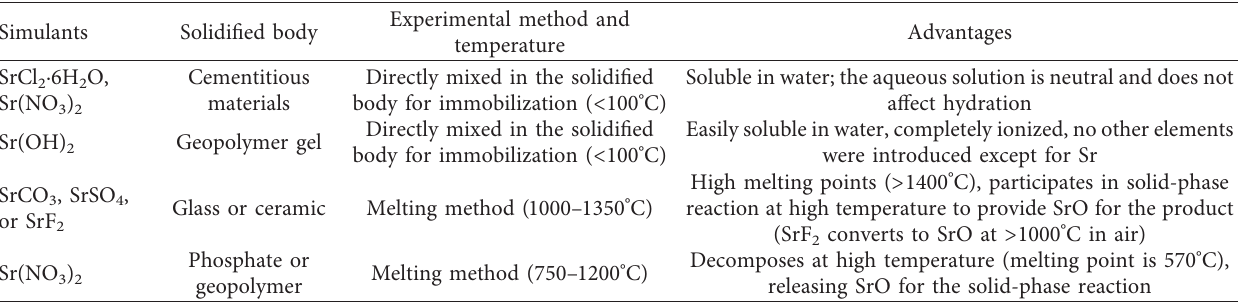
Table 5: The application conditions and advantages of the simulated 90